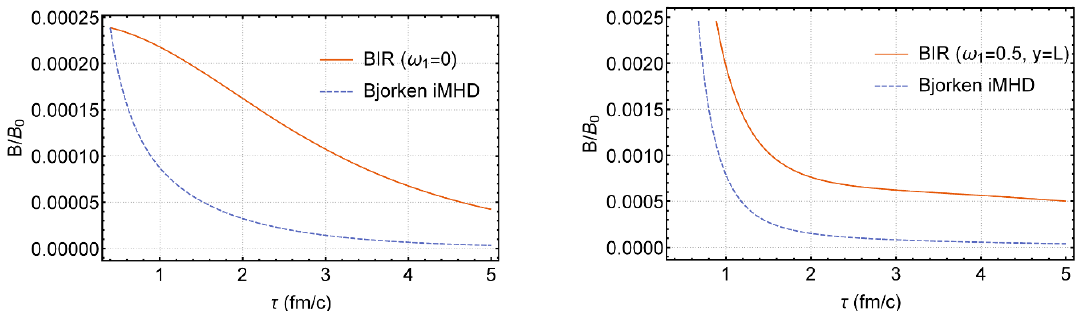
Figure 9 . (color online). A comparison of the (cid:28) -evolution of the current free solution of eq. (4.1) with Bjroken iMHD, i.e B = B 0 (cid:28) 0 . The solid line in the left picture shows the solution with (cid:28) f ! 1 = 0 ; ! 2 = 0 : 05 ; y = 0 ; x = 0 ; (cid:17) = 0 g while in the right picture it represents the solution with f ! 1 = 0 : 5 ; ! 2 = 0 : 05 ; y = L; x = 0 ; (cid:17) = 0 g is slightly weaker.